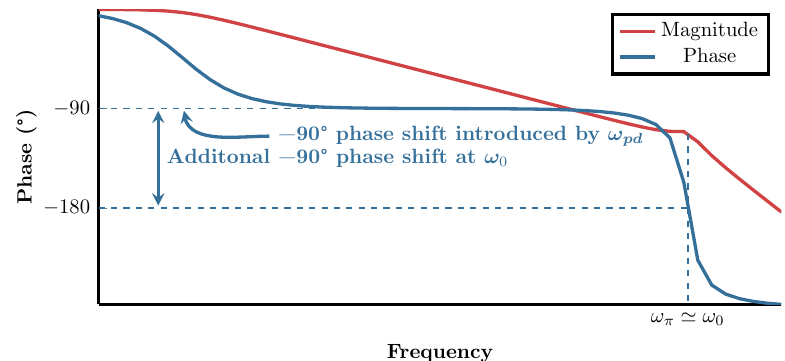
Figure 5. Conceptual Bode plot of Equation (1) illustrating that ω π